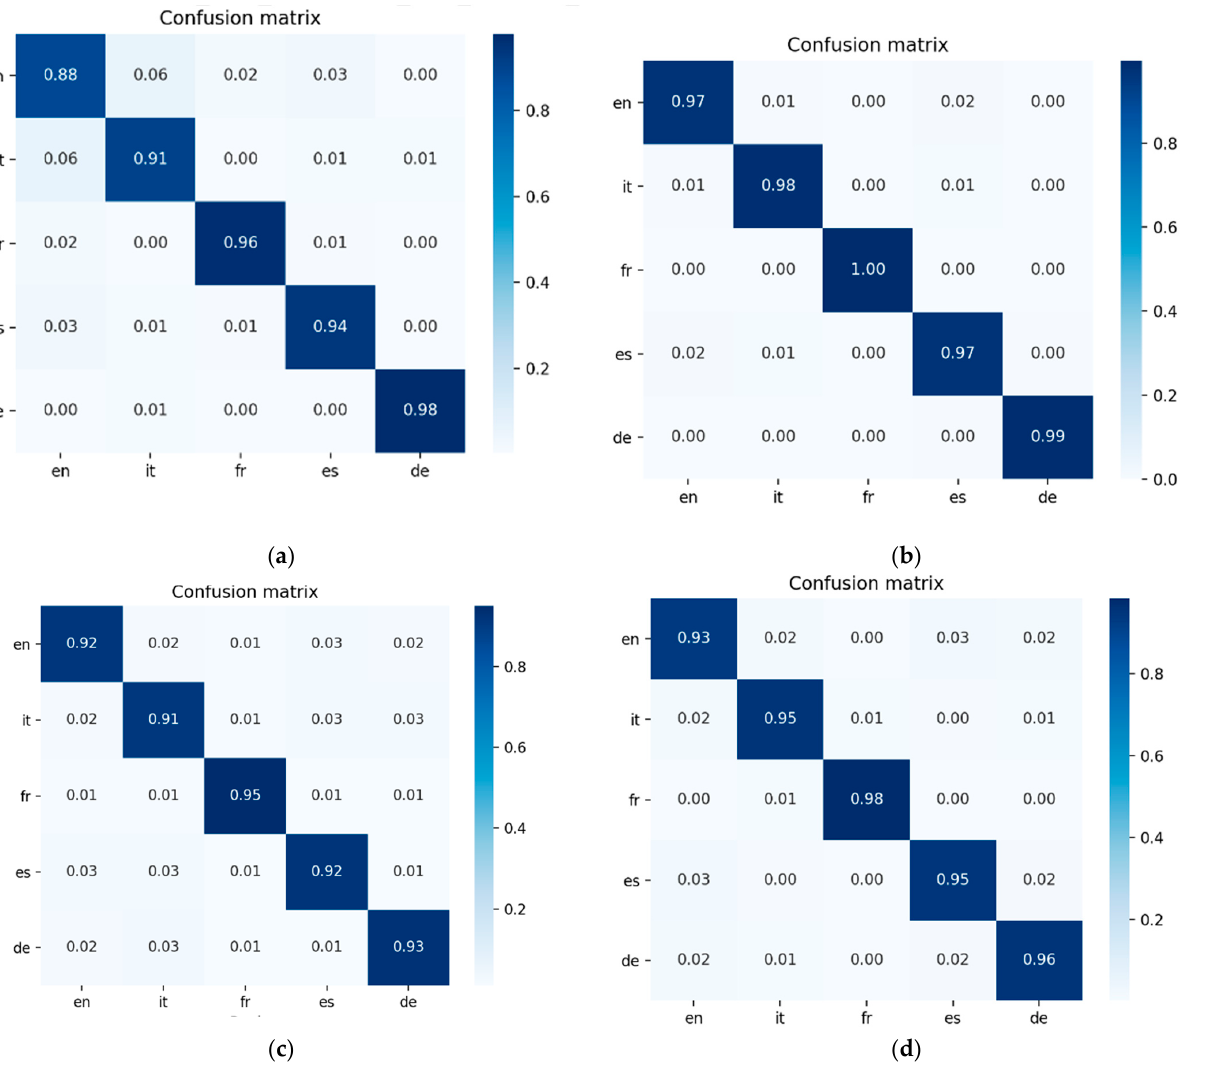
Figure 2. Feature overlapping for WIKI_NOOOV and WIKITXT datasets for 400 and 1200 elements. ( a ) WIKI_NOOOV, 400 features, trigram; ( b ) WIKI_NOOOV, 1200 features, trigram ( c ) WIKITXT, 400 features, trigram ( d ) WIKITXT, 1200 features, trigram. Table 2. Results for the classifiers trained on the WIKI _ NOOOV and WIKITXT datasets.